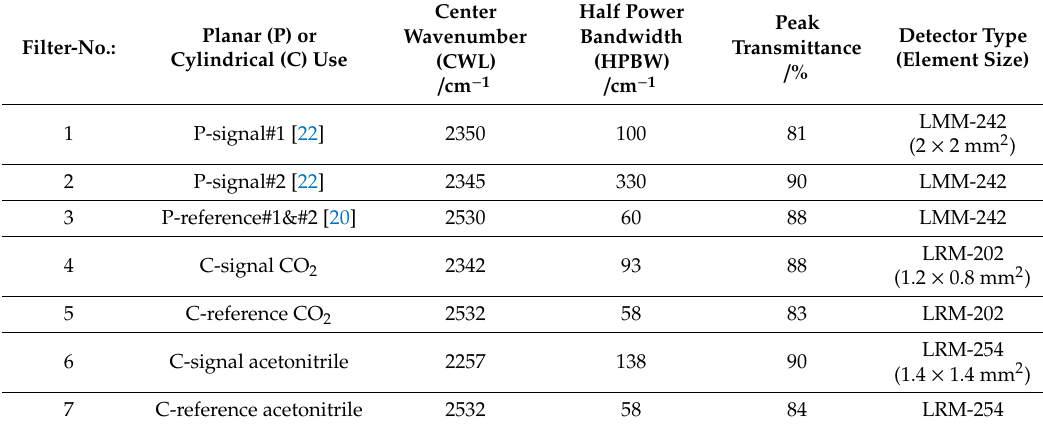
Table 1. IR filters and detectors used for planar and cylindrical photometer configurations. The filters were supplied and integrated by InfraTec GmbH into the detector housings. Data are typical datasheet values from InfraTec